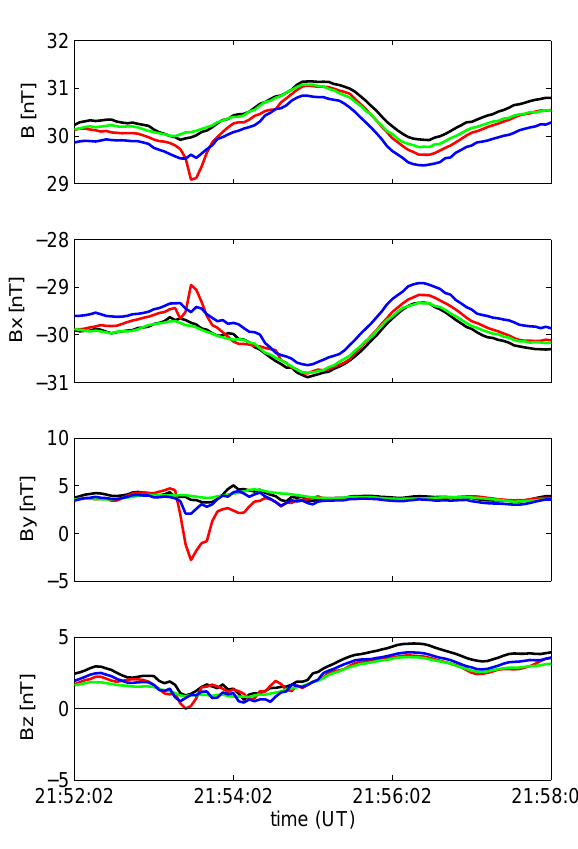
Fig. 10. TCR6: Total magnetic field B and magnetic fields B x , B y , and B z for the sixth